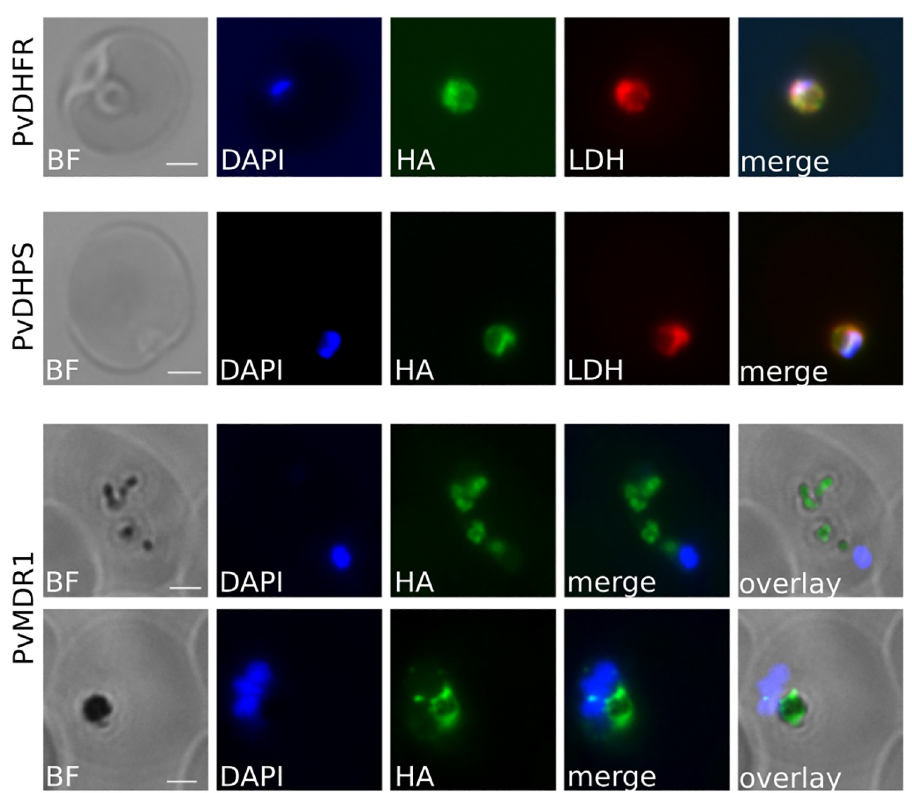
Fig 2. Localisation of PvMDR1, PvDHPS and PvDHFR in P. knowlesi by immunofluorescence. Epitope tagged P. vivax proteins were localised using a rat α -HA antibody and an AlexaFluor 1 488 secondary. LDH was imaged using rabbit α -PfLDH antibody and an AlexaFluor 1 680 secondary antibody. Scale bar 2 μ m.